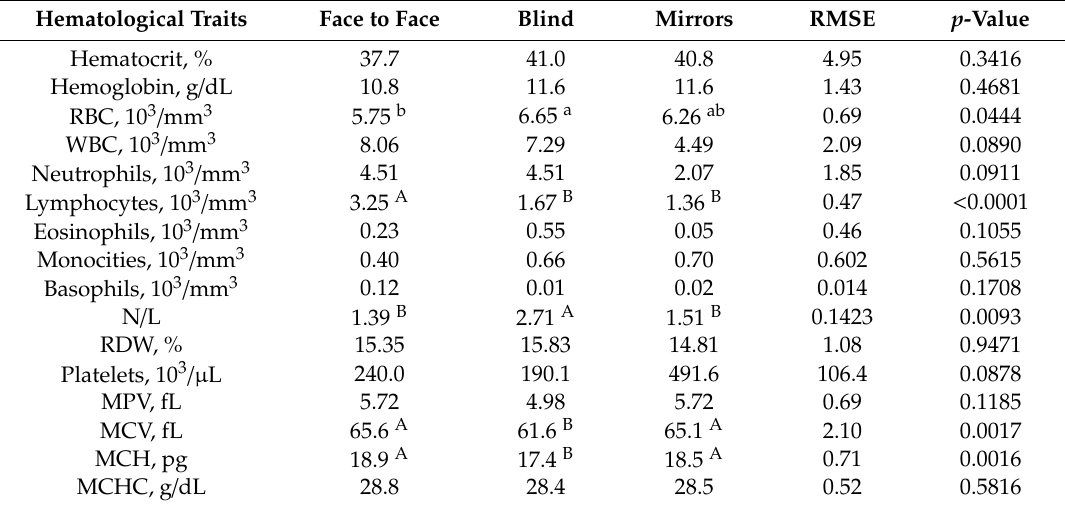
Table 7. Hematological traits of rabbits according to the housing systems. Hematological Traits Face to Face Blind Mirrors